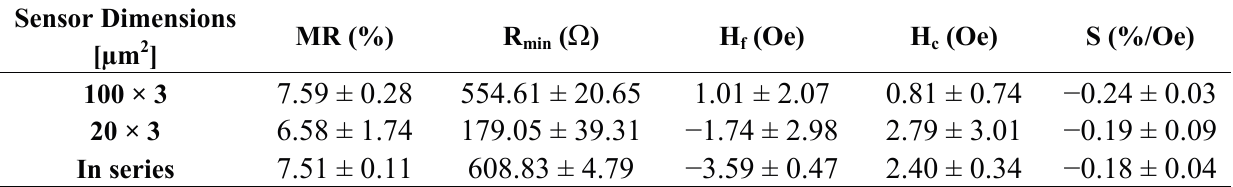
Table 1. Results of SVs transport characteristics [28 sensors